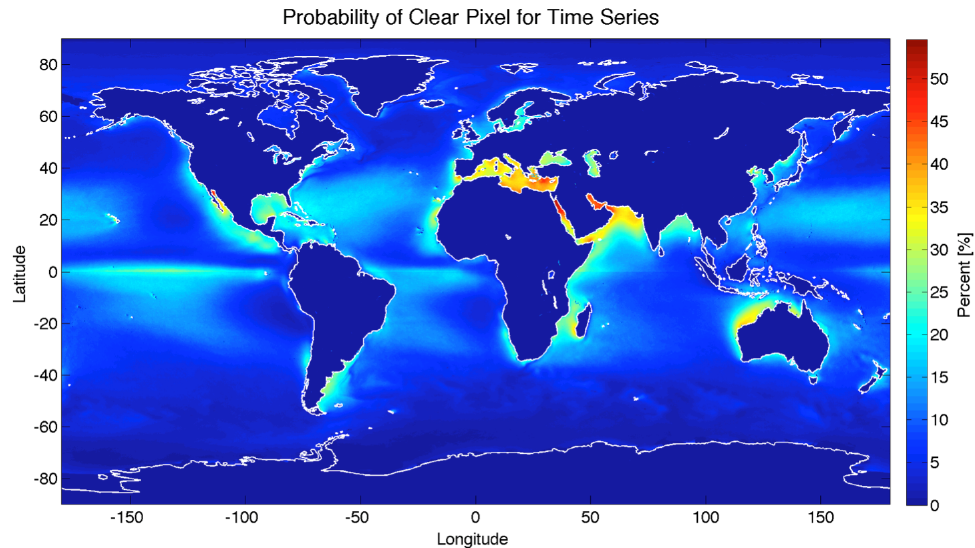
Figure 1. Probability of clear pixel for the time series (1982–2011) considered in the climatology of the maximum gradient of SST from University of Rhode Island (URI) Pathfinder 9 km frontal database (courtesy of Peter Cornillon Graduate School of Oceanography, University of Rhode Island (URI)). Figure taken from